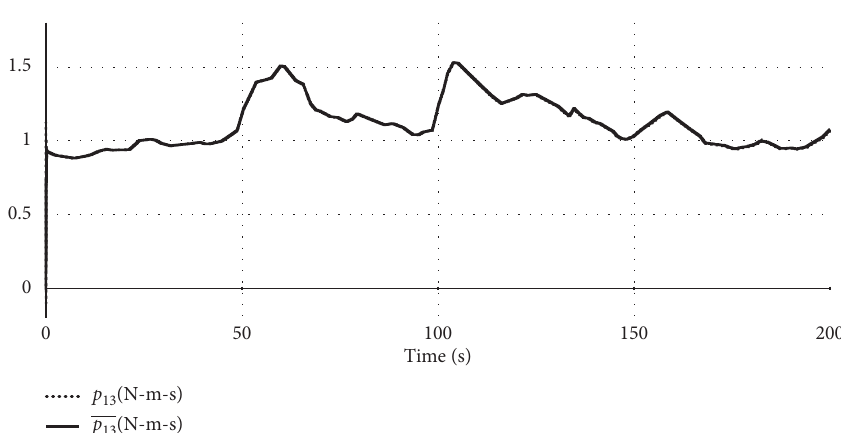
Figure 16: Full time simulation of the slow variable p